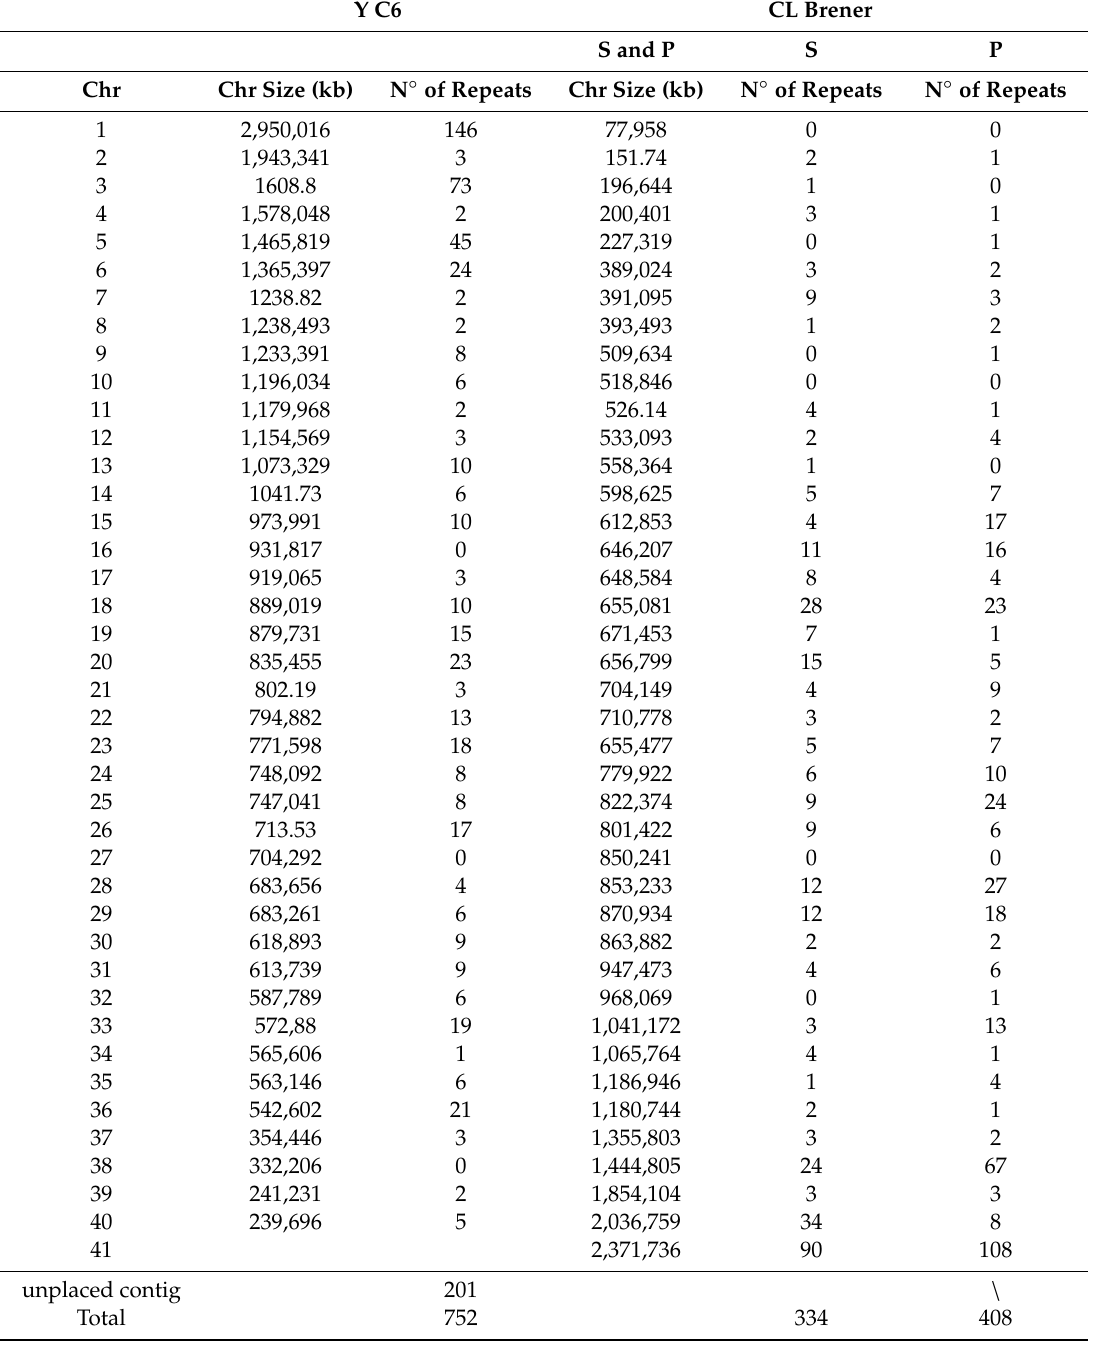
Table 2. Number of 241 nt repeats found on each chromosome of T. cruzi CL